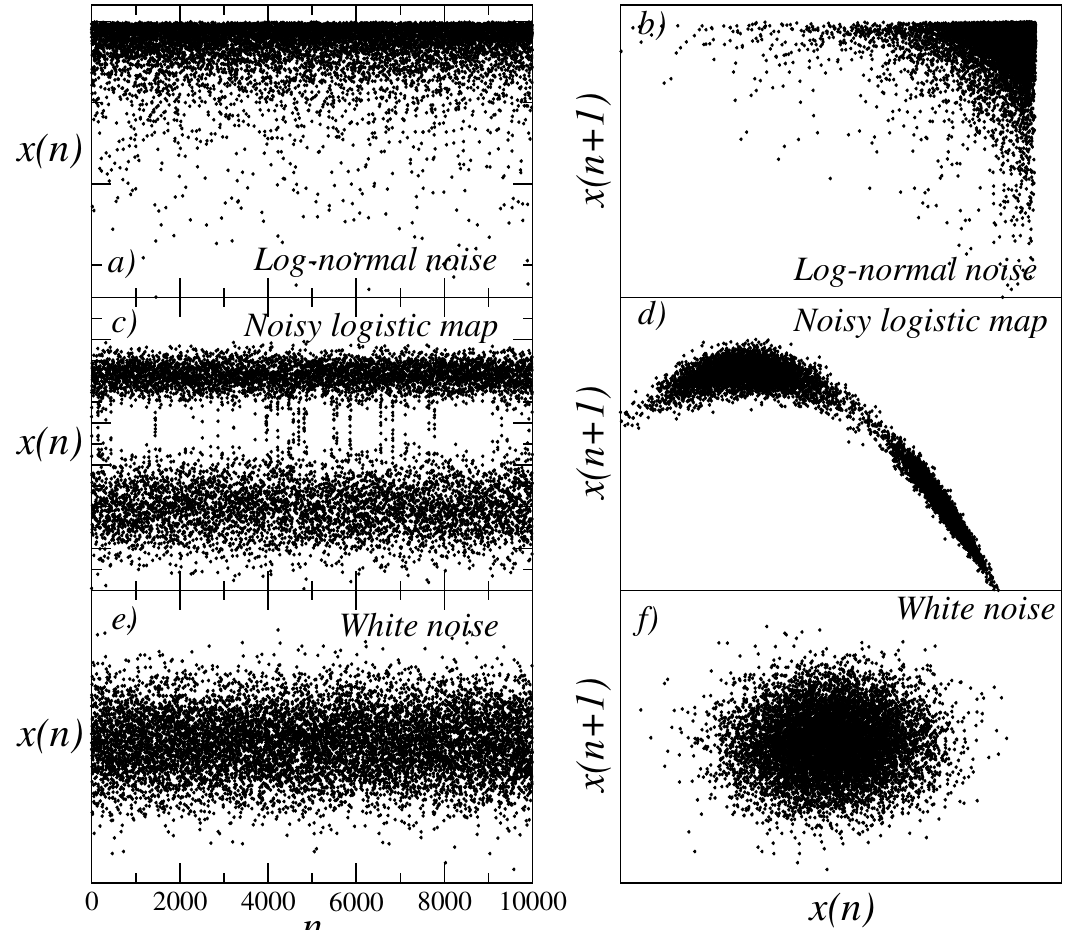
Figure 8. Signals obtained from three different random processes (( a ) Log-normal noise; ( b ) Noisy logistic map; ( c ) White noise) with their correspondent return maps (( d ) Log-normal noise; ( e ) Noisy logistic map; ( f ) White noise).